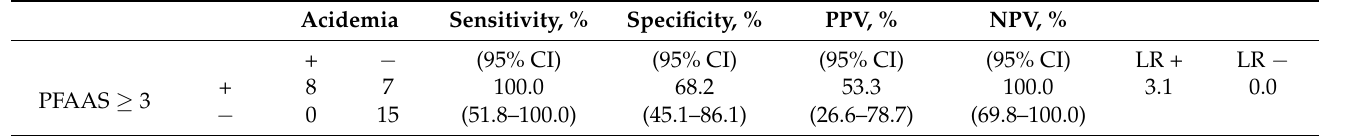
Table 6. Prediction of fetal acidemia in placental abruption using the predictive fetal acidemia in abruption score (PFAAS) in the validation set. The sensitivity, specificity, positive predictive value, and negative predictive value were 100.0%, 68.2%, 53.3%, and 100.0%, respectively. CI, confidence interval; PPV, positive predictive value; NPV, negative predictive value; LR, likelihood ratio. Acidemia Sensitivity, % Specificity, % PPV, % NPV,